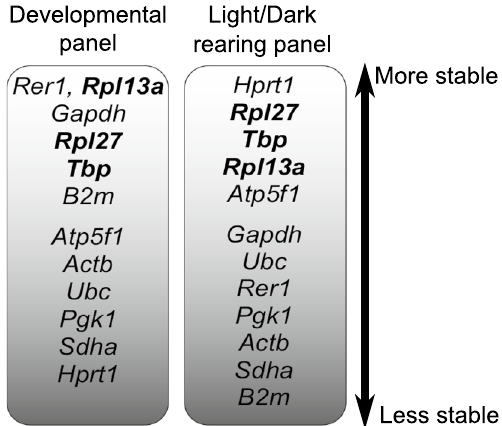
Figure 4. Summary of gene stability ranking. The 2 columns illustrate gene stability order of the 2 experimental panels with decreasing stability from top to bottom. Three genes (bold) were among the top 5 most stable for both panels.